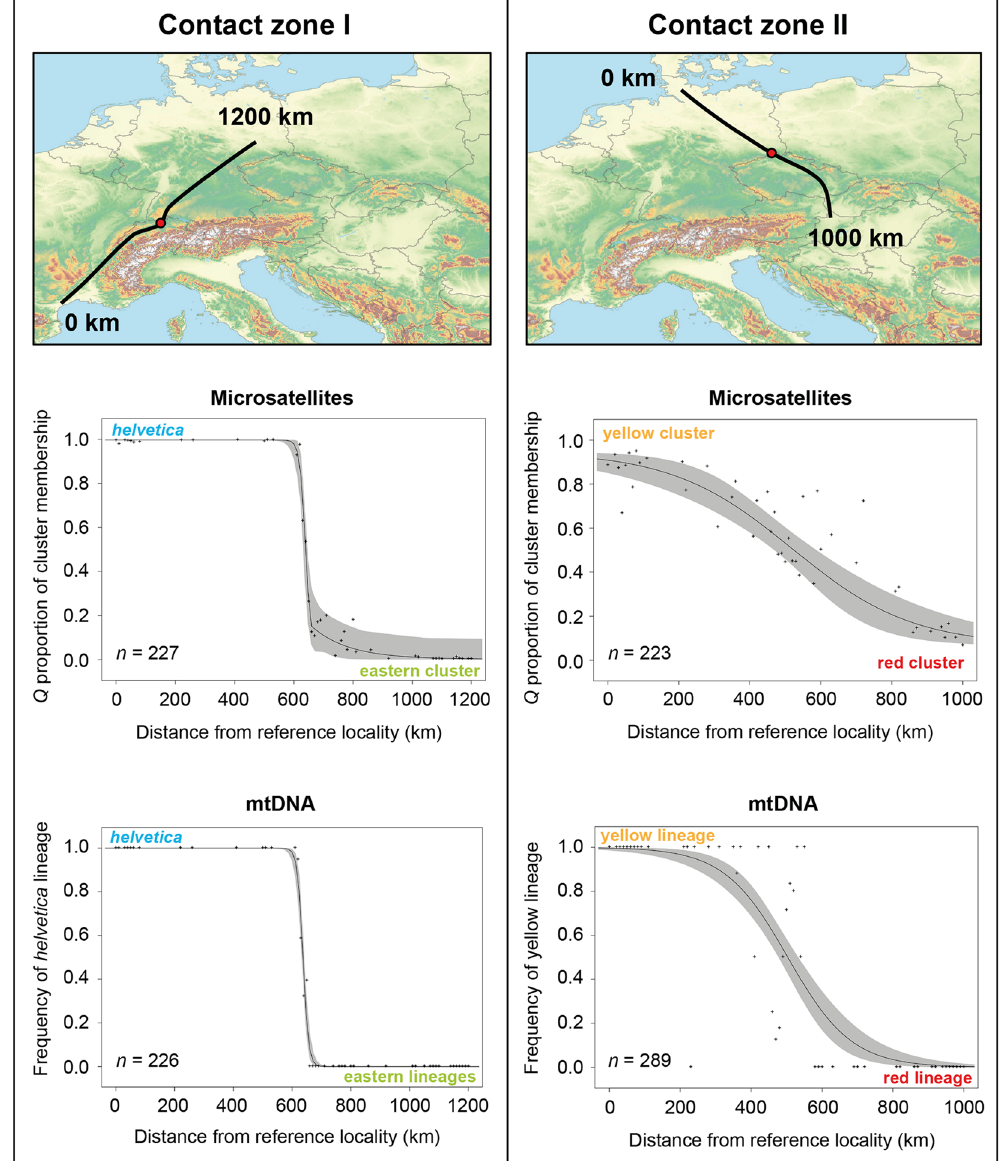
Figure 5. Cline analyses of mitochondrial DNA and microsatellite data. Transects (top) through the two different contact zones of grass snake lineages ( helvetica /eastern lineages – left; yellow/red lineages – right) and associated Maximum Likelihood clines for microsatellites (centre) and mtDNA (bottom). Grey: fuzzy 95% credible cline region. Red points (top) indicate cline centres. Maps were created using arcgis 10.2 (http://www. esri.com/arcgis) and adobe illustrator CS6